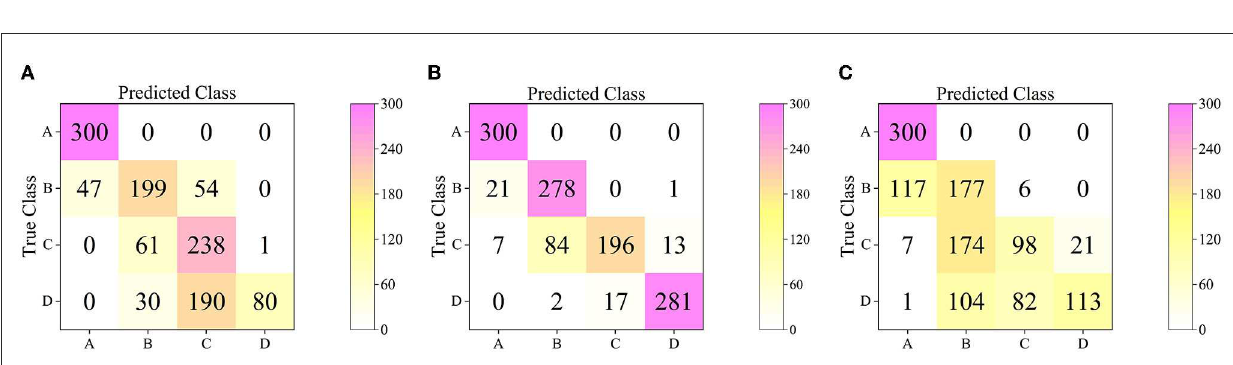
FIGURE11 The confusion matrices of DEEPMAE on AL*, Ab*, and AL*b* test datasets. (A) AL*; (B) Ab*; (C) AL*b*.